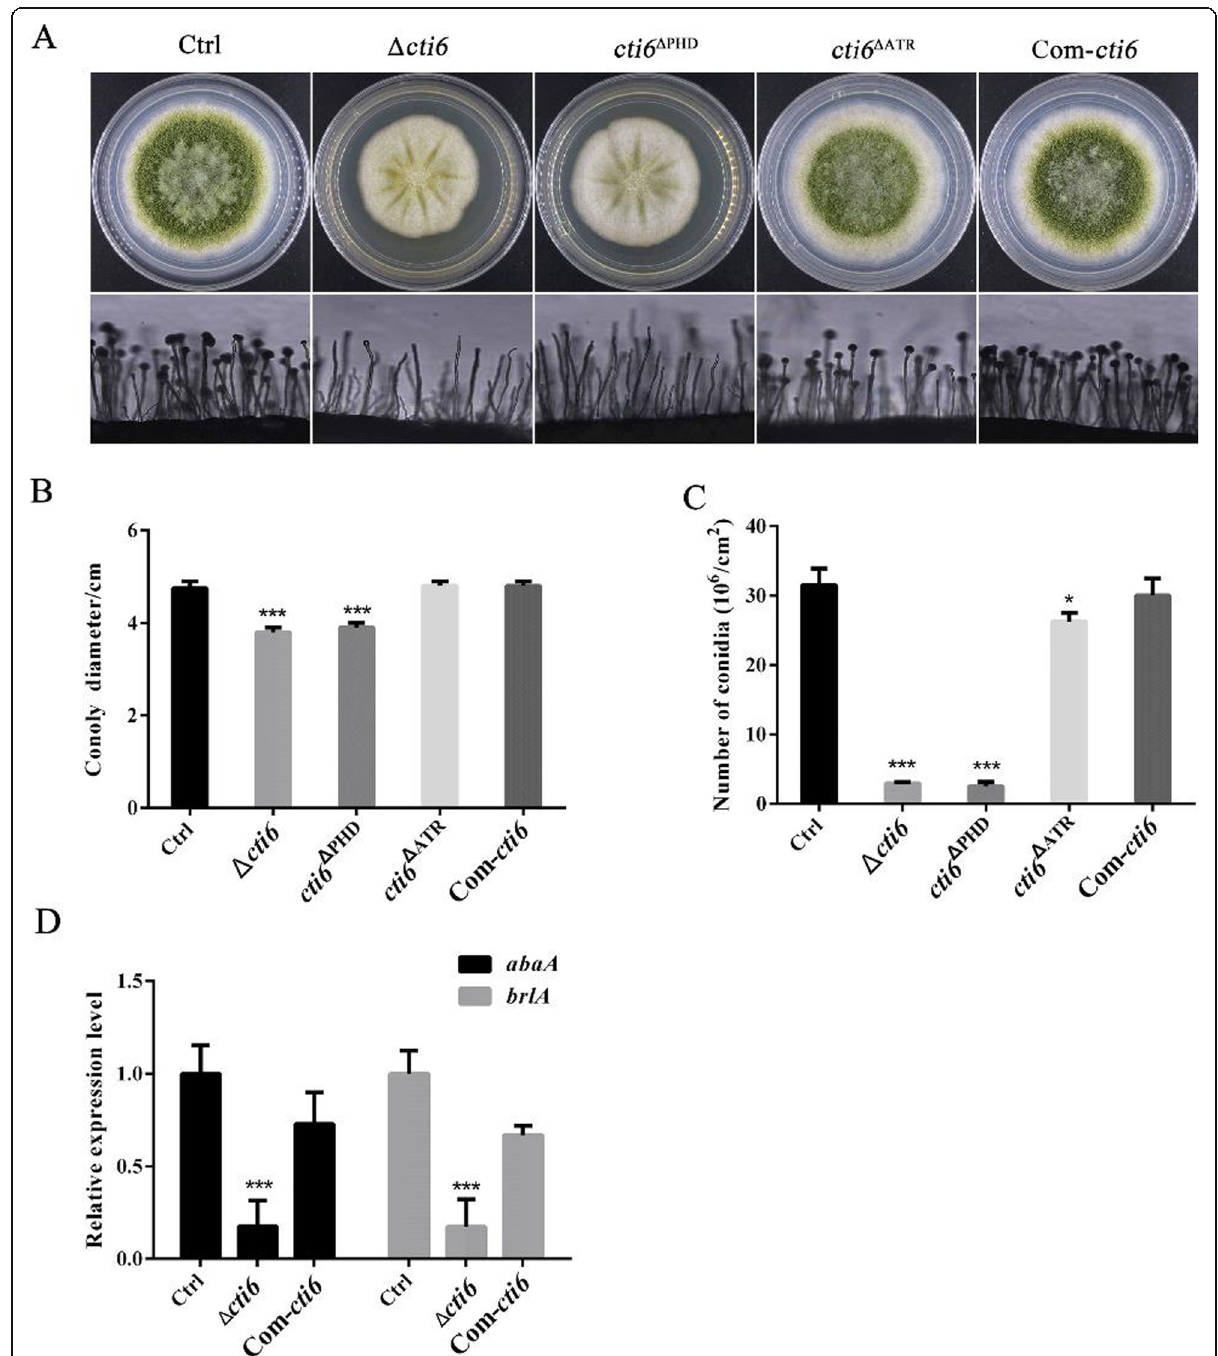
Fig. 2 Cti6 up-regulates the growth of fungal mycelium and conidiation in A. flavus . a The A. flavus strains were point-inoculated on PDA media for 5 d at 37 °C. b The colony diameters were measured and represented with column graph according to the result of ( a ) panel. c The number of conidia of each fungal strain on PDA medium. d The expression level of transcriptional factor abaA and brlA genes. The “ * ” , “ ** ” and “ *** ” represents significant difference levels: p < 0.01, p < 0.005 and p < 0.001, respectively. All experiments were carried out with three biological replicates, and repeated at least three